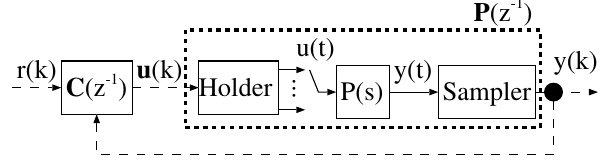
Figure 1. Block diagram of a dual-rate sampled-data system.